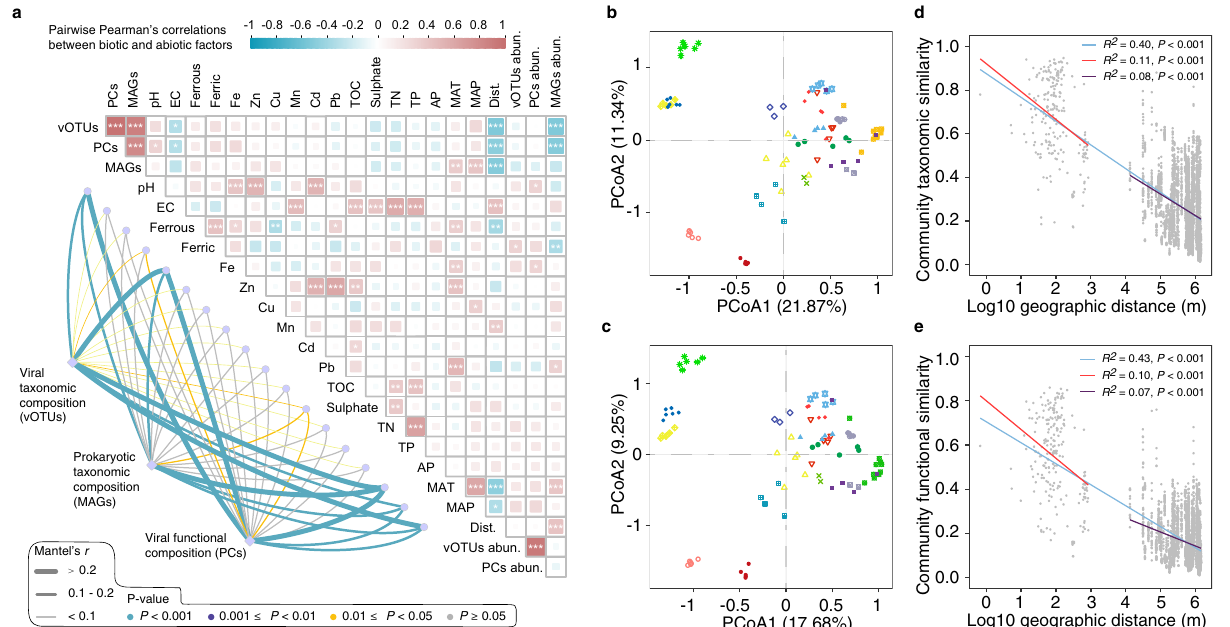
Fig. 2 Dynamics of viral populations and functions. a Pairwise comparisons of the biotic and abiotic variables. The color gradient in the heatmap denotes Pearson ’ s correlation coef fi cients and the asterisk indicates two-tailed test of Pearson ’ s statistical signi fi cance adjusted using the Benjamini and Hochberg false discovery rate controlling procedure. * P < 0.05, ** P < 0.01 and *** P < 0.001. Edge width corresponds to the Mantel ’ s r statistic for the corresponding distance correlations, and edge color denotes the statistical signi fi cance. vOTUs, the number of viral operational taxonomic units; PCs, the number of viral protein clusters; MAGs, the number of metagenome-assembled genomes; EC, electronic conductivity; Ferrous, ferrous iron; Ferric, ferric iron; TOC, total organic carbon; TN, total nitrogen; TP, total phosphorus; AP, available phosphorus; MAT, mean annual temperature; MAP, mean annual precipitation; Dist., distance from the equator; vOTUs abun., the abundance of viruses; and PCs abun., the abundance of viral functions. b , c Principal coordinate analysis (PCoA) of viral taxonomic b and functional ( c ) structure colored by sampling sites. d , e Distance-decay relationships (DDRs) based on Bray-Curtis similarity (1 - dissimilarity) of viral taxonomic d and functional e community compositions. The blue line denotes the least-squares linear regression across all spatial scales. Red and purple lines denote separate regressions within samples whose distance ≤ 1 km and within samples whose distance > 1 km, respectively. Color-coded best- fi t lines and adjusted R 2 values for each DDR are presented. The statistical test used was two-tailed. Source data are provided in the Source Data fi with higher MAP and lower prokaryotic richness. The other direct drivers of viral taxonomic and functional abundance were ferric iron ( r = 0.23, P < 0.01) and pH ( r = 0.20, P < 0.05).